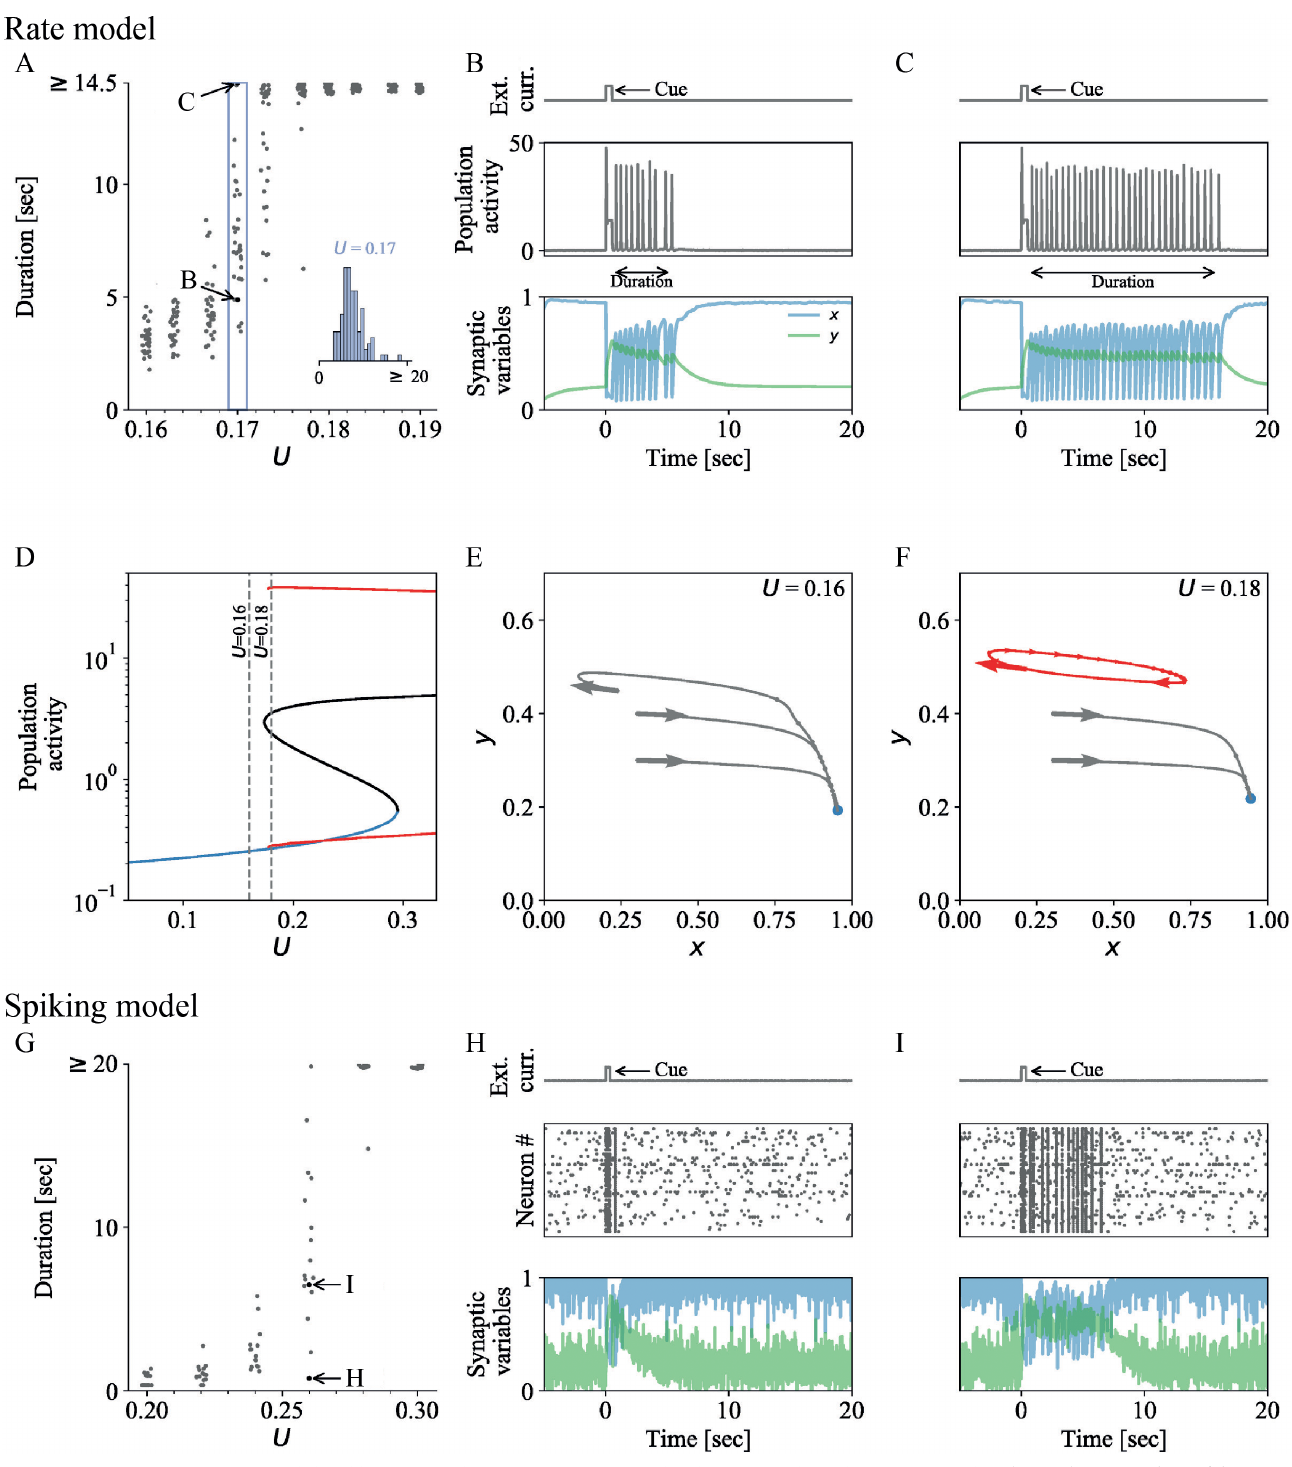
PLOS Computational Biology | https://doi.org/10.1371/journal.pcbi.1010543 October 3,